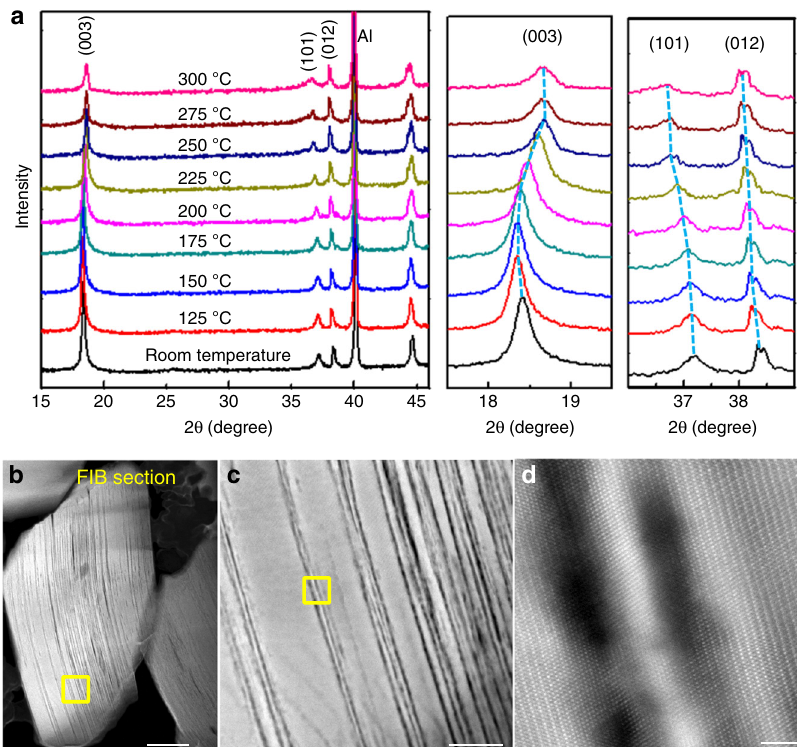
Fig. 5 Evolution of LiNi 0.6 Mn 0.2 Co 0.2 O 2 charged to 4.7 V during heating. a In situ X-ray diffraction (XRD) measurements. b – d Direct high angle annular dark fi eld (HAADF) observation of the inner bulk degradation at gradually increased magni fi cations, enabled by focus ion beam (FIB) milled cross-section sample. The yellow square region in ( b ) is enlarged as ( c ) and the yellow square region in ( c ) is enlarged as ( d ). The scale bars are 200 nm in ( b ), 50 nm in ( c ), and 2 nm in ( d